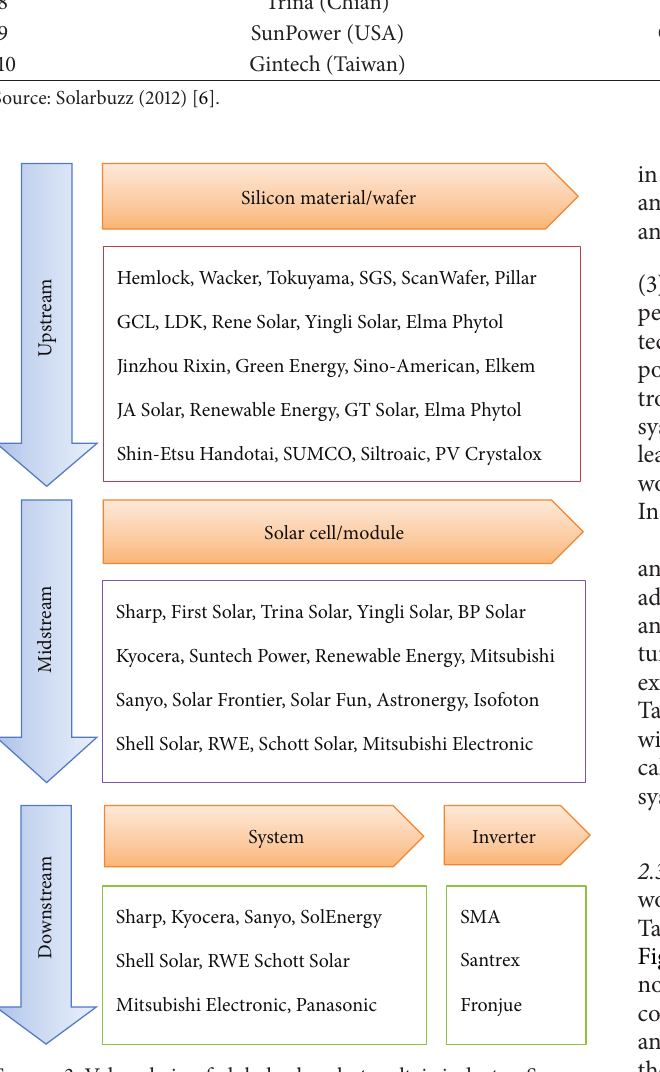
Figure 3: Value chain of global solar photovoltaic industry. Source: PHOTON International (2012) [11] and ITRI (2012)